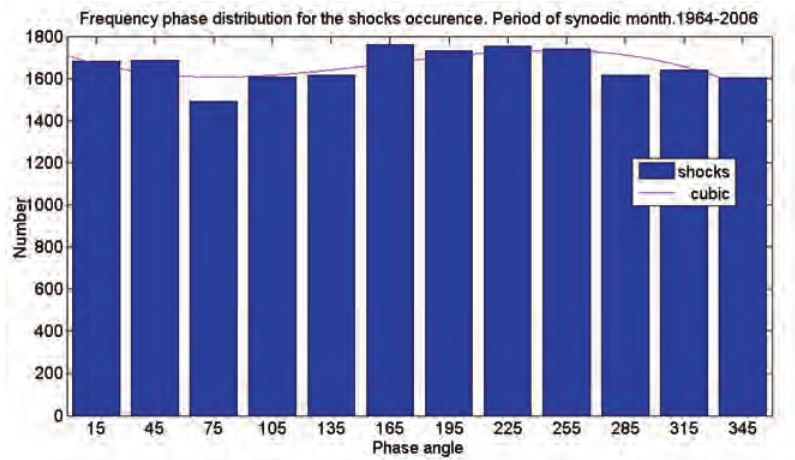
Figure 7. Cumulative histogram corresponding to the monthly synodic period, of all of the 19.916